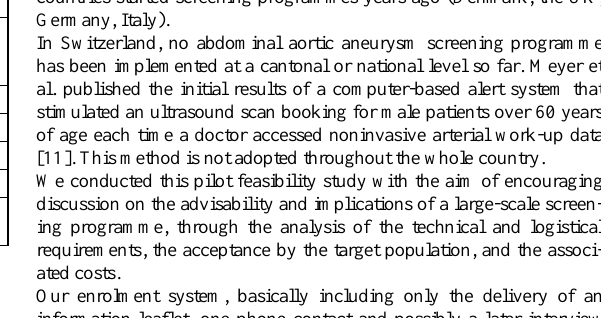
Table 1: Abdominal aortic aneurysm screening acceptance rate by age category (eligible patients).